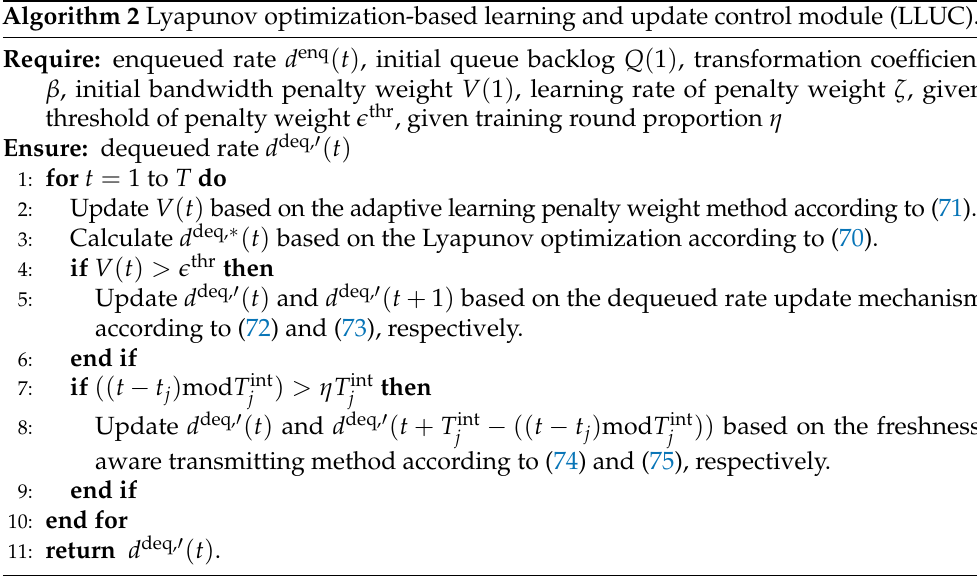
Algorithm 2 Lyapunov optimization-based learning and update control module